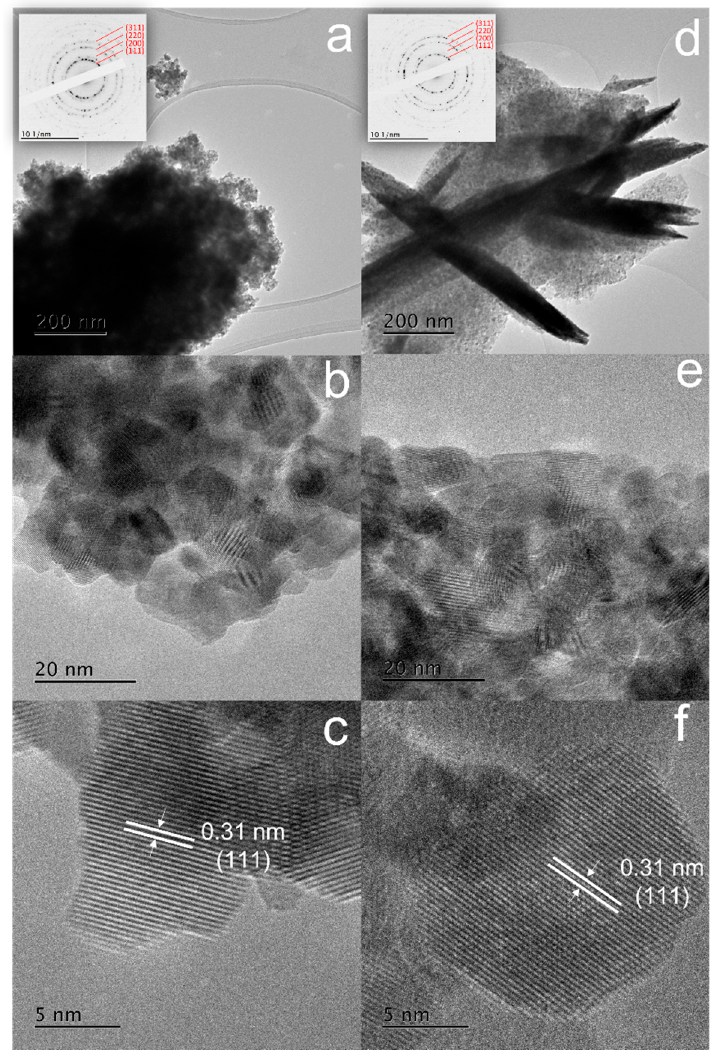
Figure 5. Transmission electron microscopy images and selected area electron diffraction patterns of ( a – c ) CeO 2 (IV) and ( d – f ) CeO 2 (III) catalysts.